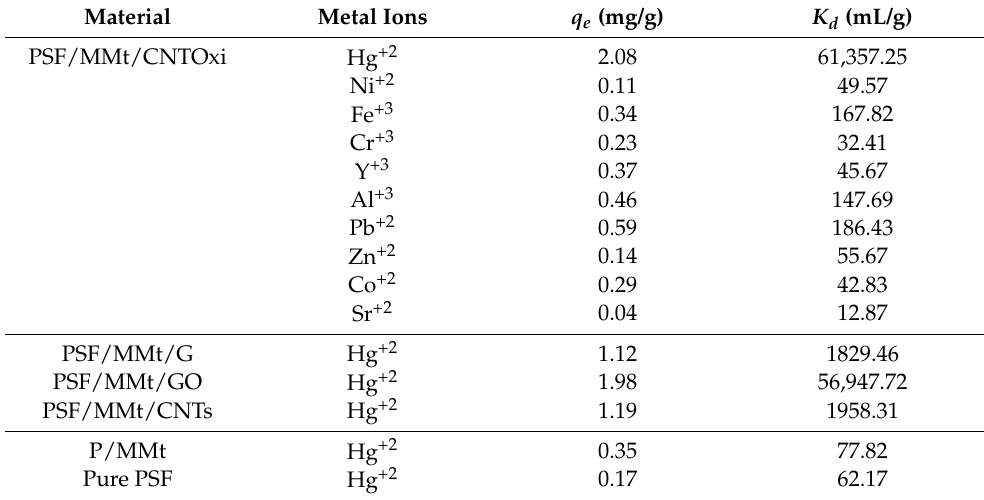
Table 5. Surface selectivity study on the adsorption of pure PSF, PSF/MMt,